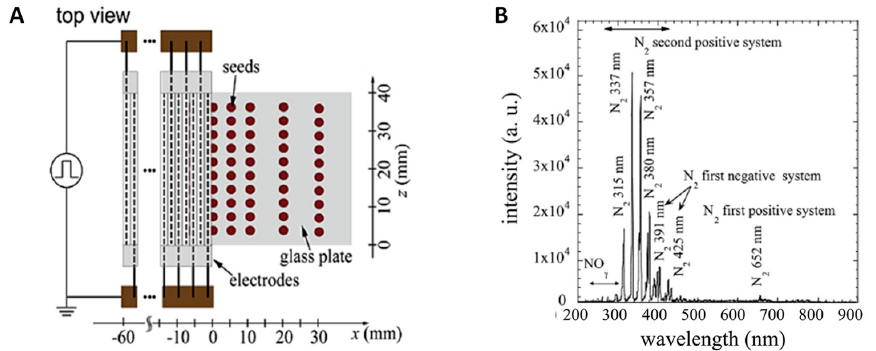
Figure 8. Schematic diagram of atmospheric pressure DBD device ( A ) and optical emission spectrum of air plasma ( B ).